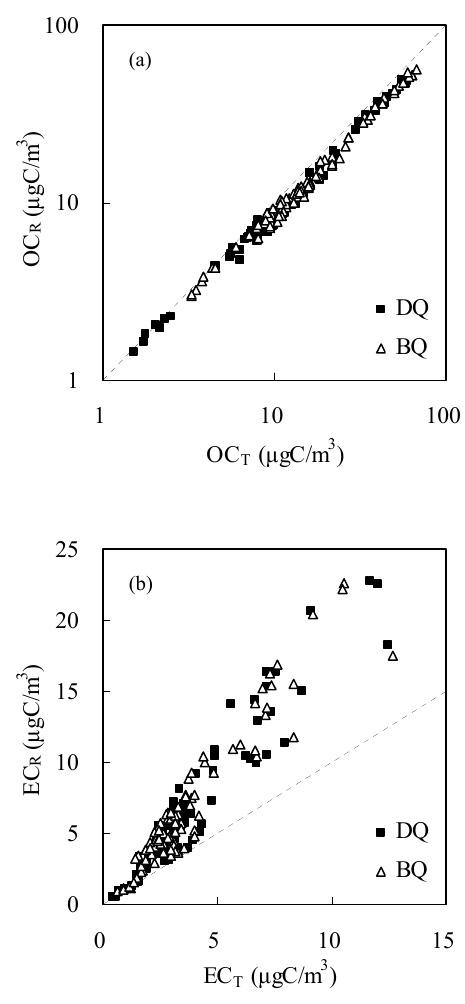
Fig. 3. Comparison of (a) transmittance-defined OC (OC T ) and reflectance-defined OC (OC R ) and (b) transmittance-defined EC (EC T ) and reflectance-defined EC (EC R ). Results were obtained from IMPROVE-A temperature protocol (He4-580 protocol). Results from parallel denuded (DQ) and undenuded (BQ) quartz filters are shown separately.